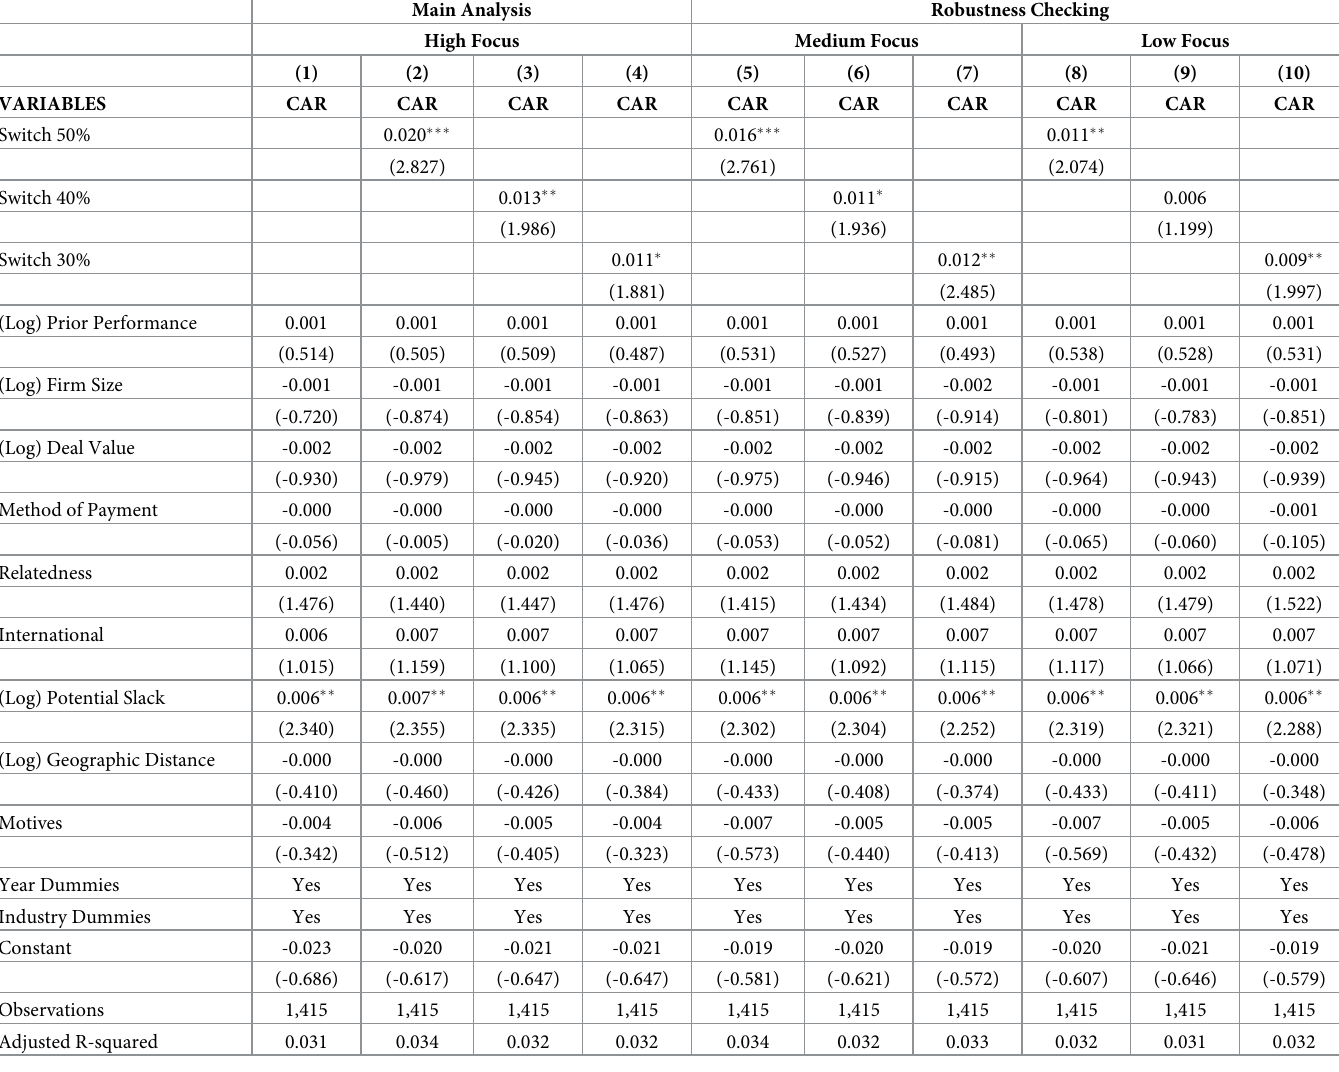
Table 4. H1 regression